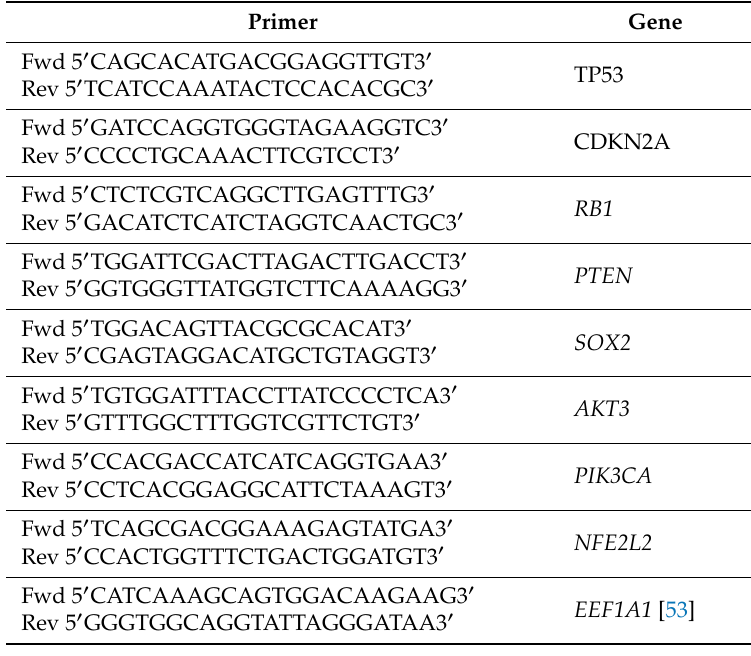
Table 1. All primers where indentified from the Harvard Primer Database , except EEF1A1.